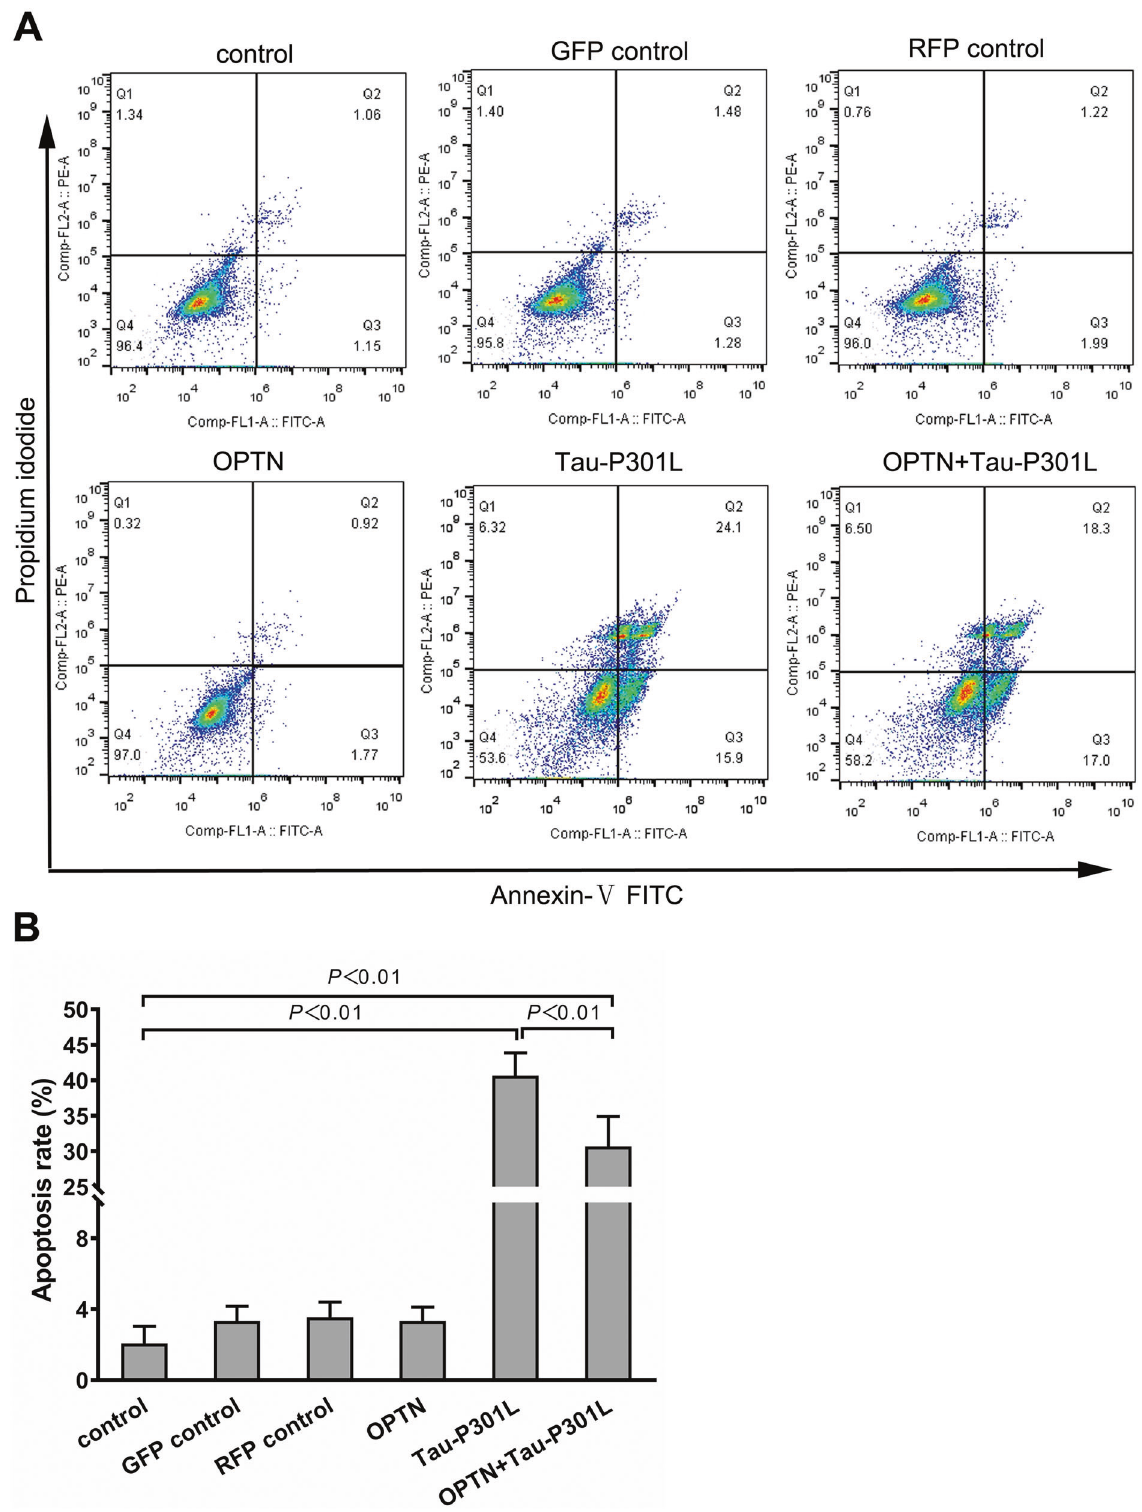
Fig. 2 AAV- OPTN reduced the apoptosis of neuronal cell line HT22 infected with AAV- MAPT -P301L for 72 h in vitro. A Representative fl ow cytometry dot plot of neuronal cell HT22 line stained with annexin-V-FITC and PI. B Histogram of apoptosis rates of neuro cell line. The data are shown as means ± SD, the experiment was performed with triplicate in two independent sets. GFP green fl uorescent protein, RFP red fl uorescent